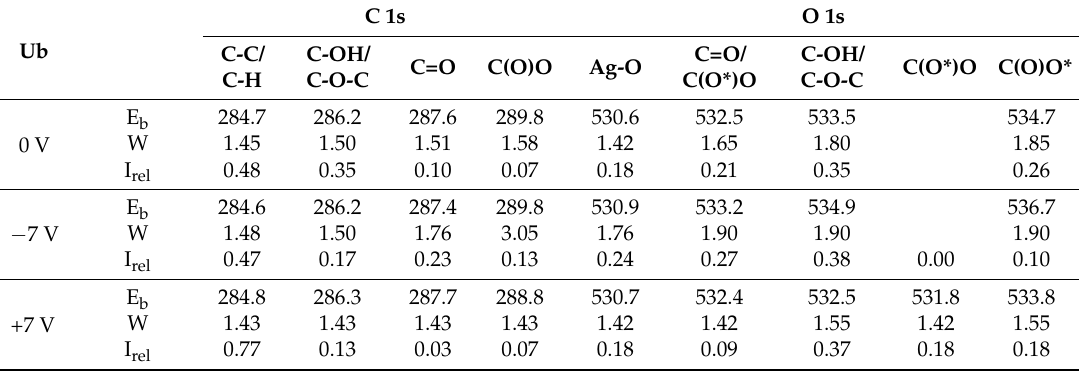
Figure 7. Fitting the C 1s photoelectron spectra of Ag black measured at U b = − 7, 0 and 7 V.